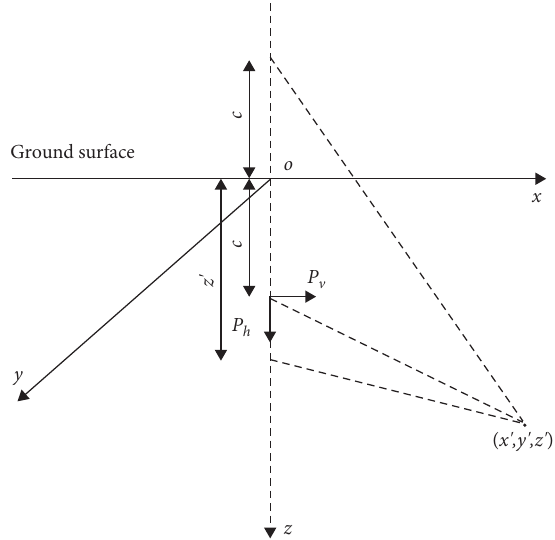
Figure 1: A schematic diagram of the Mindlin solution